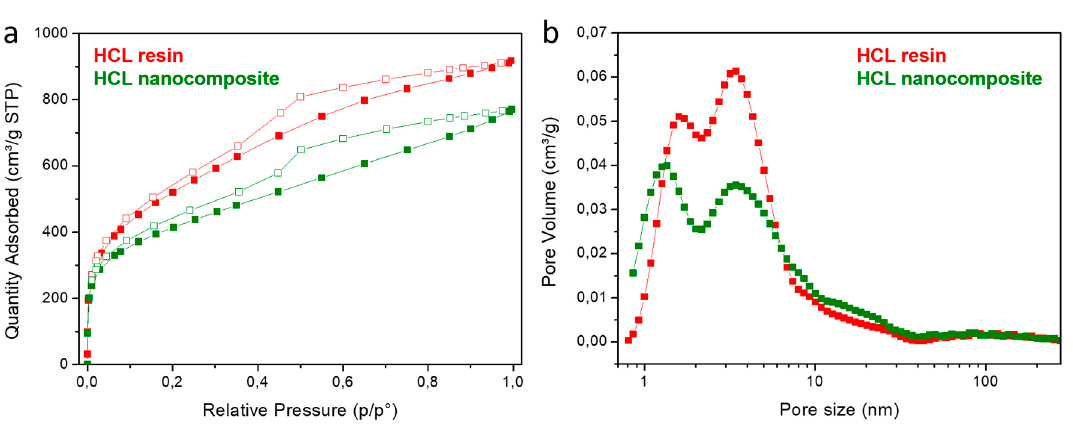
Figure 5. Nitrogen adsorption (filled symbols) and desorption (empty symbols) isotherms at 77 K ( a ) and DFT pore size distribution ( b ) of the HCL resin and HCL nanocomposites.